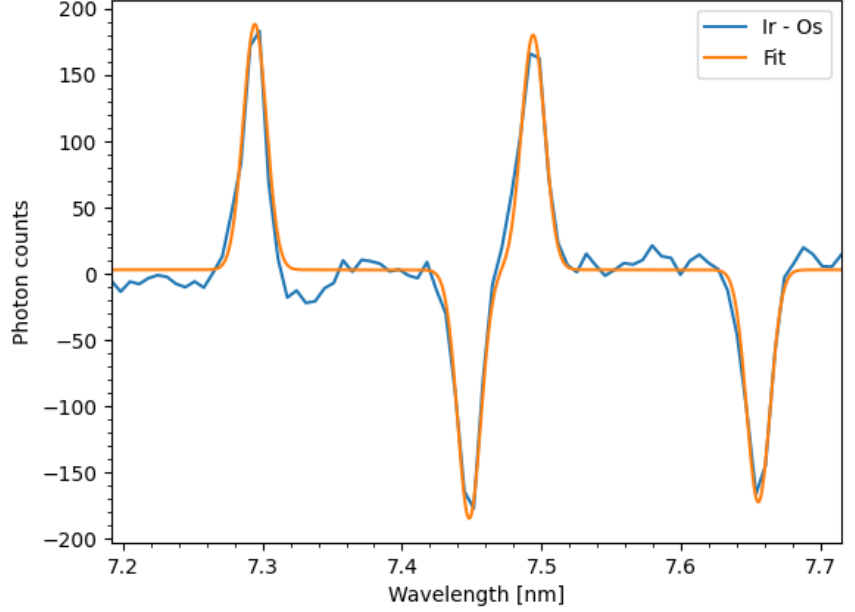
Figure 2. Subtracted spectra between the two spectra given in Figure 1 fitted with a sum of four Gaussian functions plus a constant